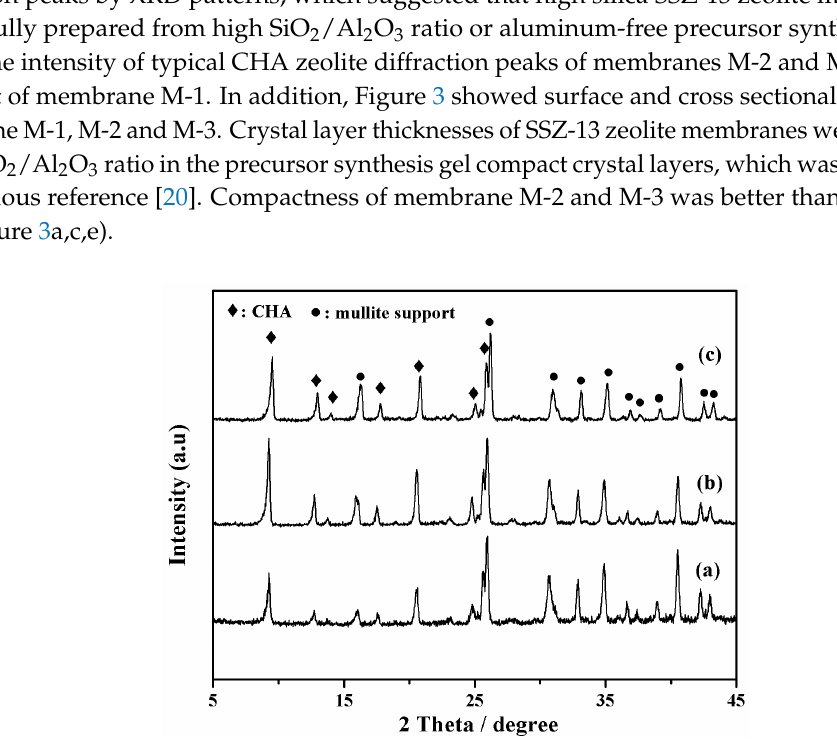
Figure 2. XRD patterns of high silica SSZ-13 zeolite membranes with different SiO 2 /Al 2 O 3 ratio; ( a ) M-1, SiO 2 /Al 2 O 3 = 40; ( b ) M-2, SiO 2 /Al 2 O 3 =200; ( c ) M-3, SiO 2 /Al 2 O 3 = ∞ .